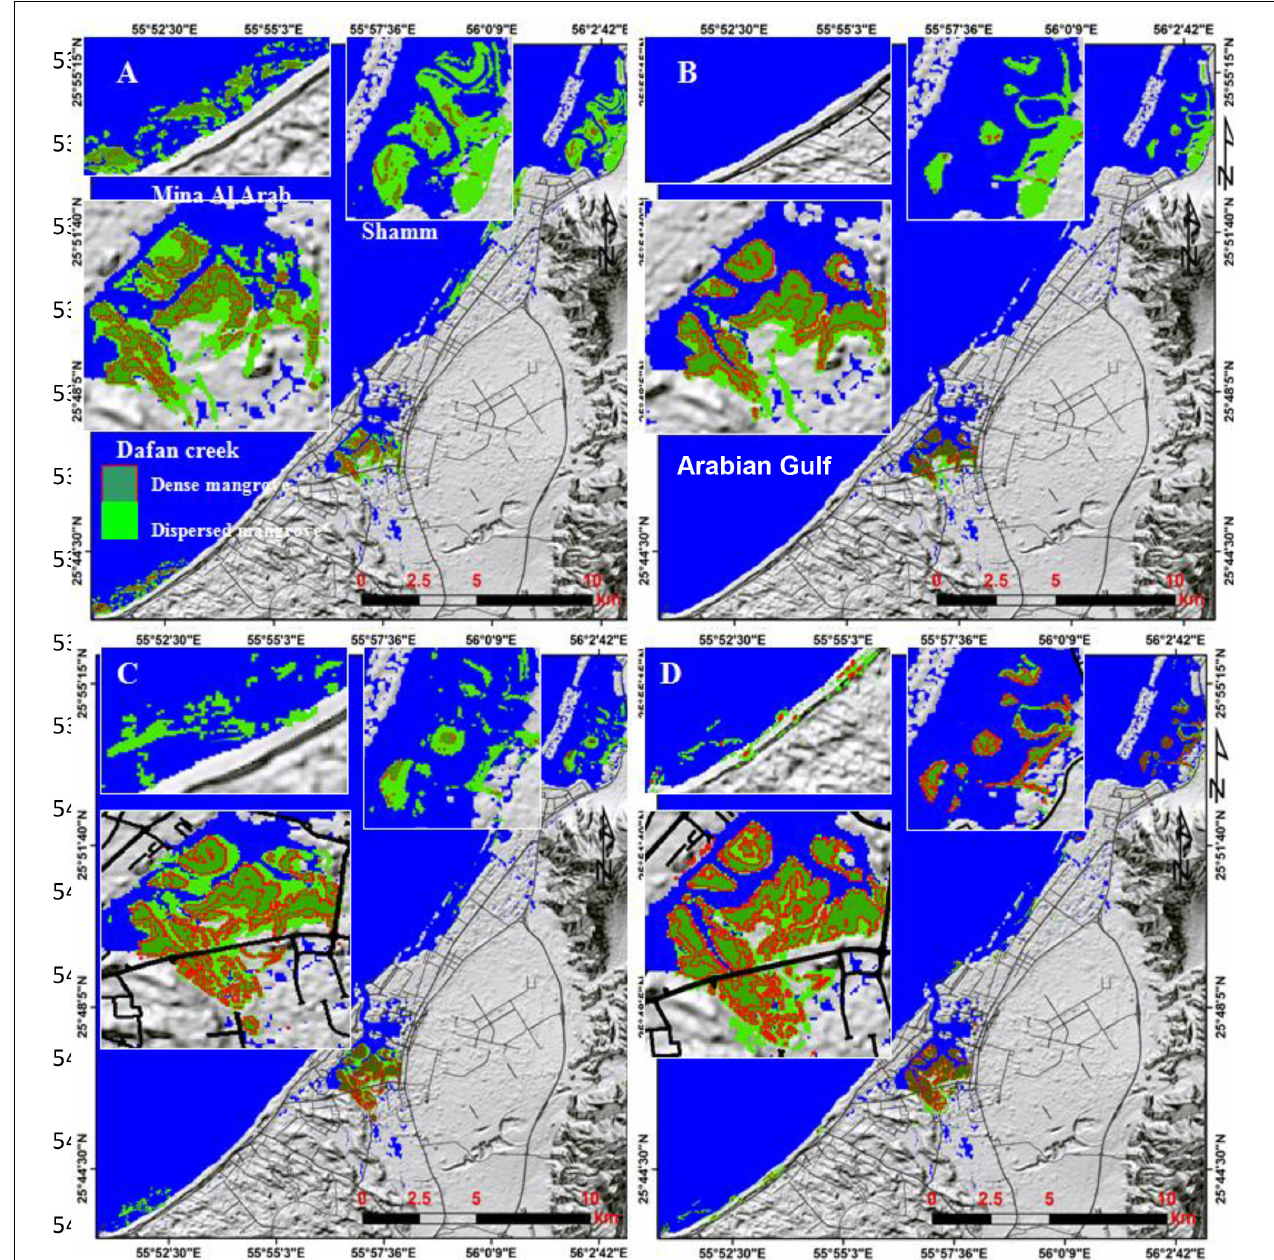
FIGURE 8 | Spatiotemporal variation of mangrove forests on the coastal area of RAK for the years 1990 (A) , 2000 (B) , 2010 (C) , and 2019 (D) and zooms of Mina Al Arab (southwest), Dafan creek (middle), and Shamm (northeast). Red polygons and dark green highlight dense